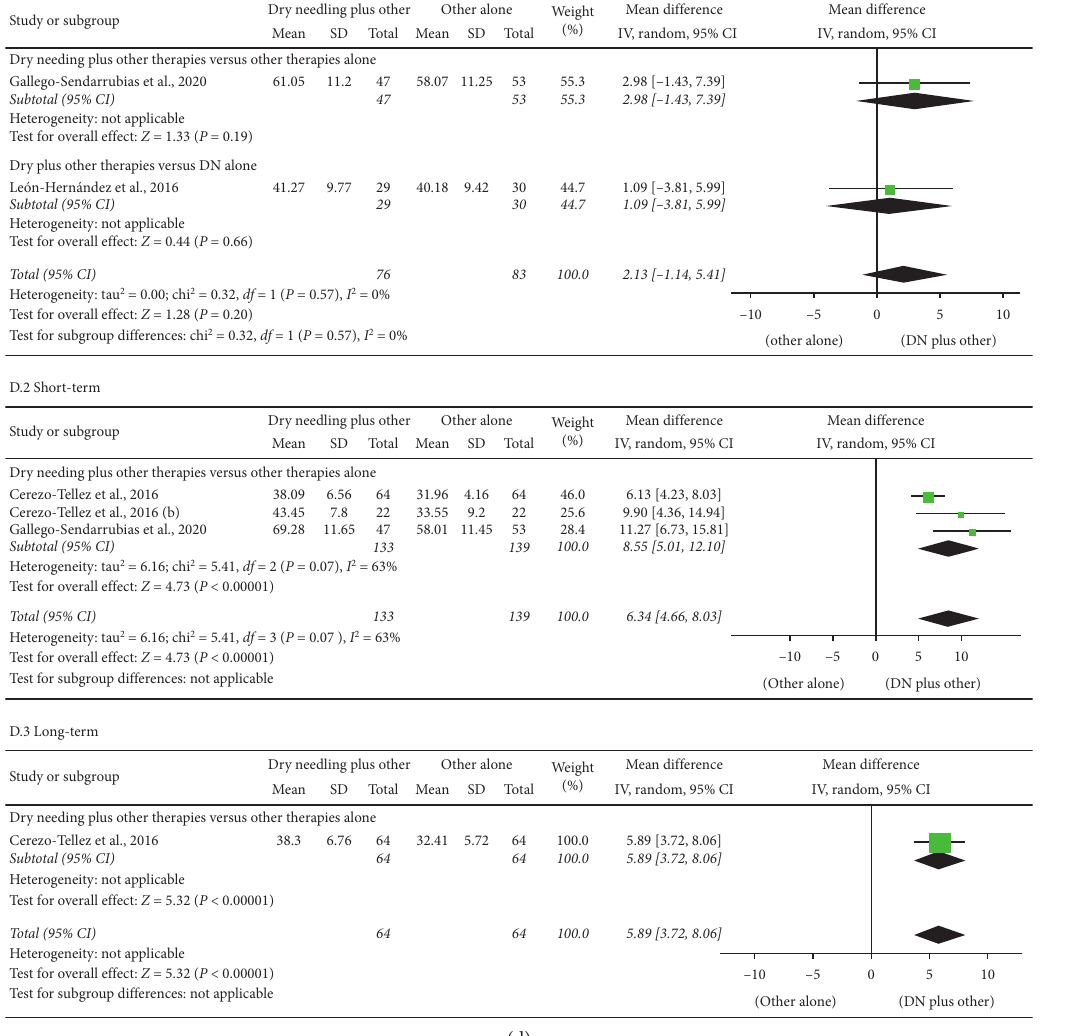
Figure 6: Comparison (mean differences) between the effects of dry needling combined with other interventions against other interventions on cervical range of motion in flexion (a), extension (b), rotation (c), and lateral-flexion (d) motion (1) immediately after, (2) at short-term, and (3) at